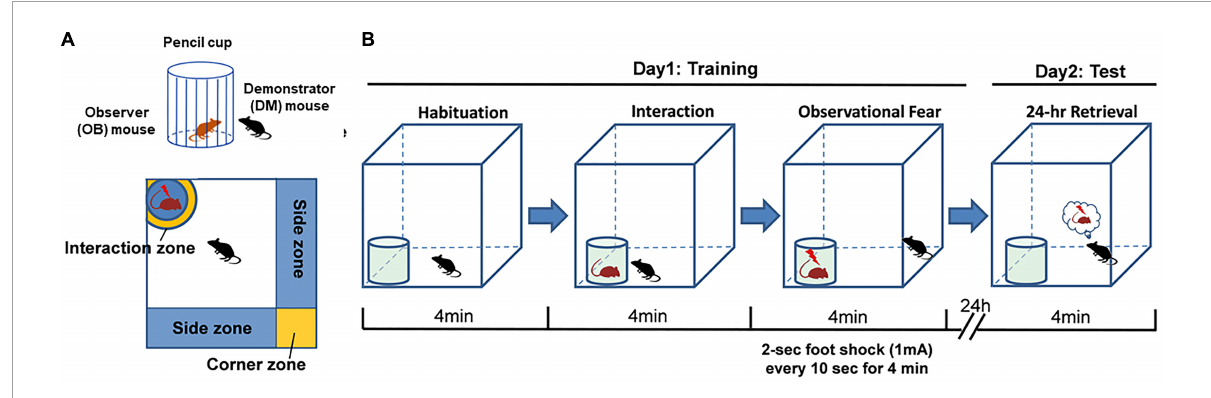
FIGURE1 Modified observational fear learning in the mouse. (A,B) Diagram of the apparatus used for observational fear conditioning and the scheme of the behavioral